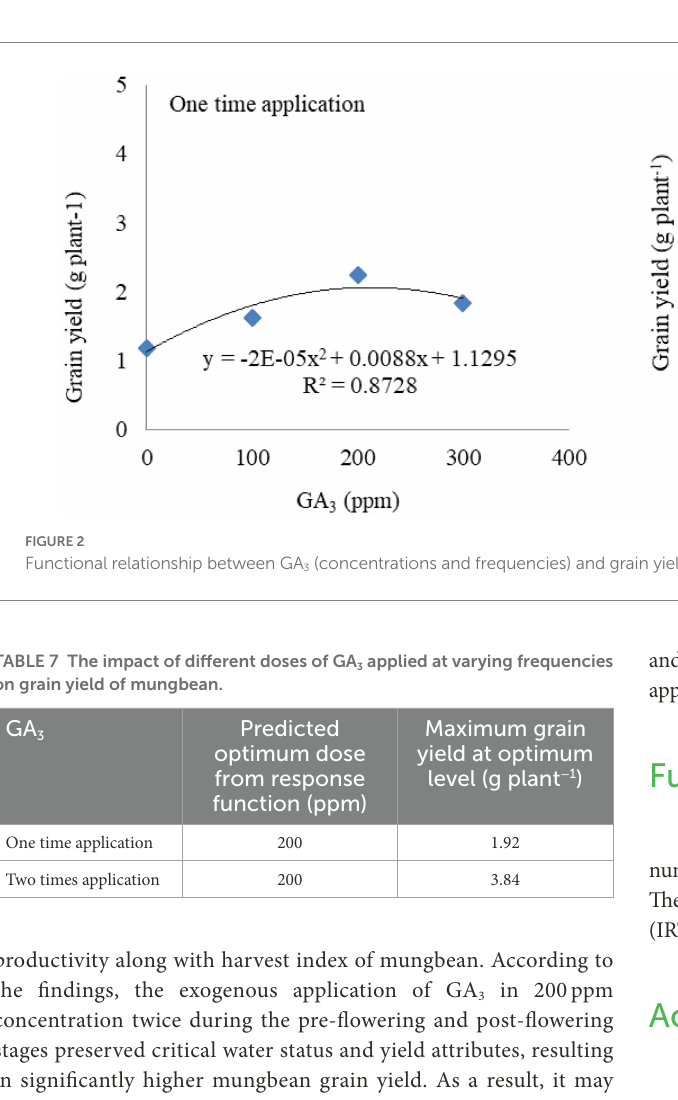
Maximum grain yield at optimum level (g plant − 1